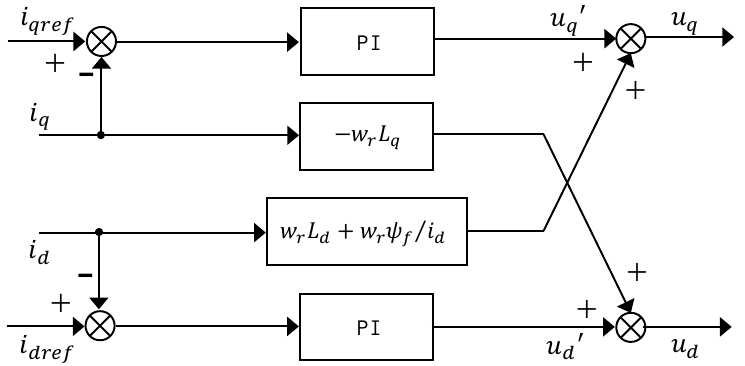
Figure 3. Structure of the voltage feed-forward decoupling